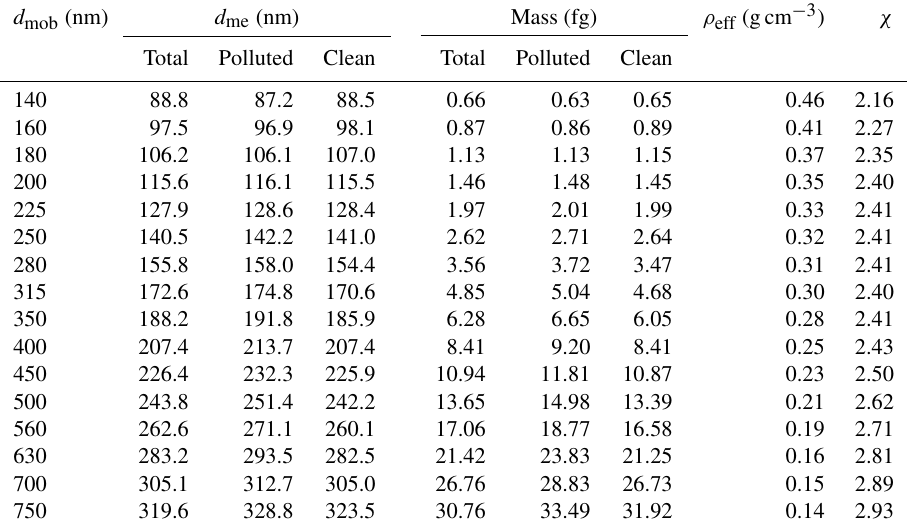
Table 1. The typical mass-equivalent diameters ( d me ) and corresponding masses of extBC for different mobility sizes ( d mob ) selected by the DMA in the whole campaign, in a polluted episode and in a clean period. The effective densities ( ρ eff ) and dynamic shape factors ( χ ) at the d mob selected by the DMA throughout the whole campaign are also